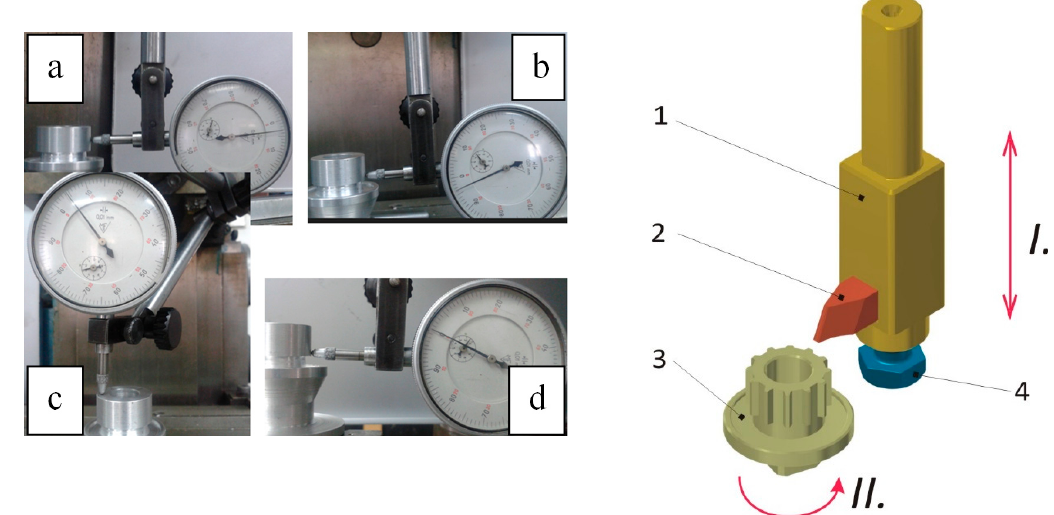
Figure 4. Measurement of deviations of fixing the part in the universal of the index head of FUS 22 machine tool: measuring the radial beat ( a ); axial deviation out of the X direction measurement ( b ); measuring frontal beat ( c ); axial deviation out of the Y direction measurement ( d );